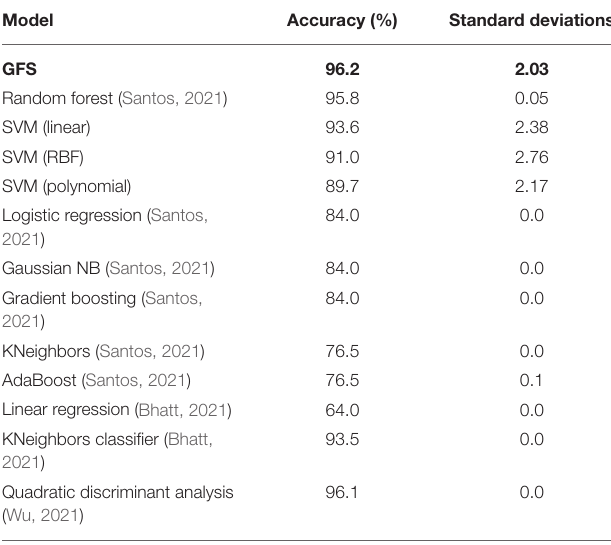
TABLE 5 | List of parameters and values used in the experiments.